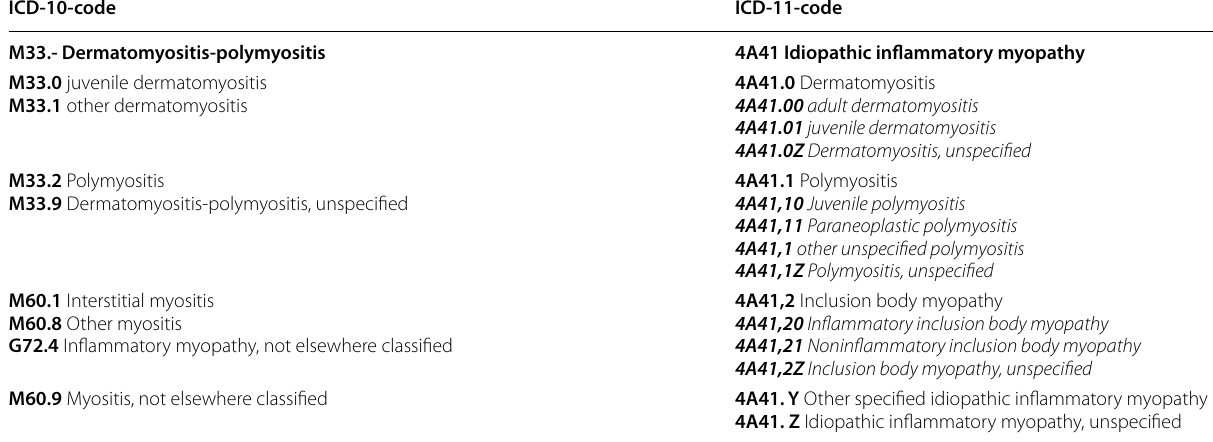
Table 2 Comparison of ICD‑10 and ICD‑11 coding for myositis with a focus on idiopathic inflammatory myopathies